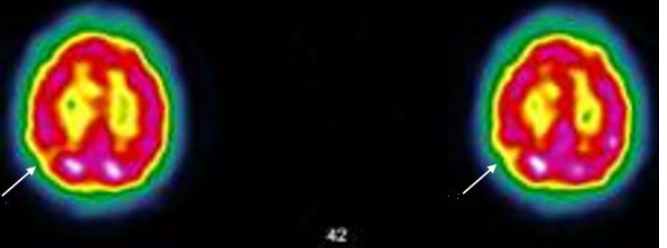
Figure 5. Case MGA005 ; SPECT-CT (ECD Tc-99m) of 25/05/21; The image shows two brain sections of the same patient. The red areas indicate a good tracer fixation and thus a good perfusion. Yellow patches (see arrows) appearing in red areas indicate hypofixation and thus ischemia Protocol; “ heterogeneous tracer fixation with clearer hypofixations left frontal, left parietal, right parietal. No preservation of the sensory-motor cortices. The fixation in front of the grey nuclei and the cerebellum is correct. Presence of periventricular hypocaptation. Conclusion: Evidence of heterogeneous tracer fixation and periventricular hypocaptation compatible with vascular-type cerebral damage. ” (Images and protocol; Drs Bouazza & Mahy, Vésale Hospital, ISPPC,